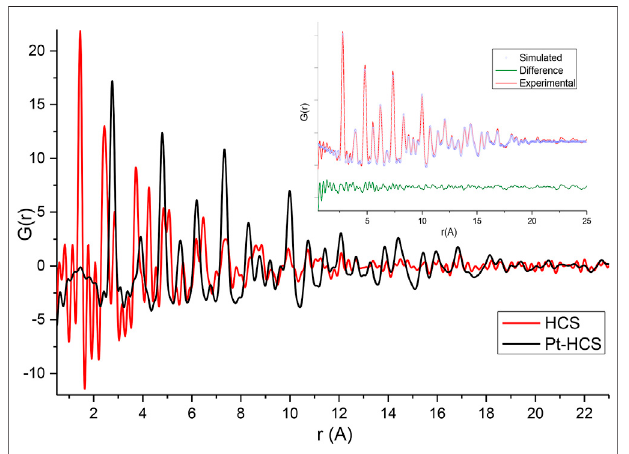
FIGURE 5 | Experimental G(r) of NHCSs and Pt/NHCSs. Insert — PDF fi tting of